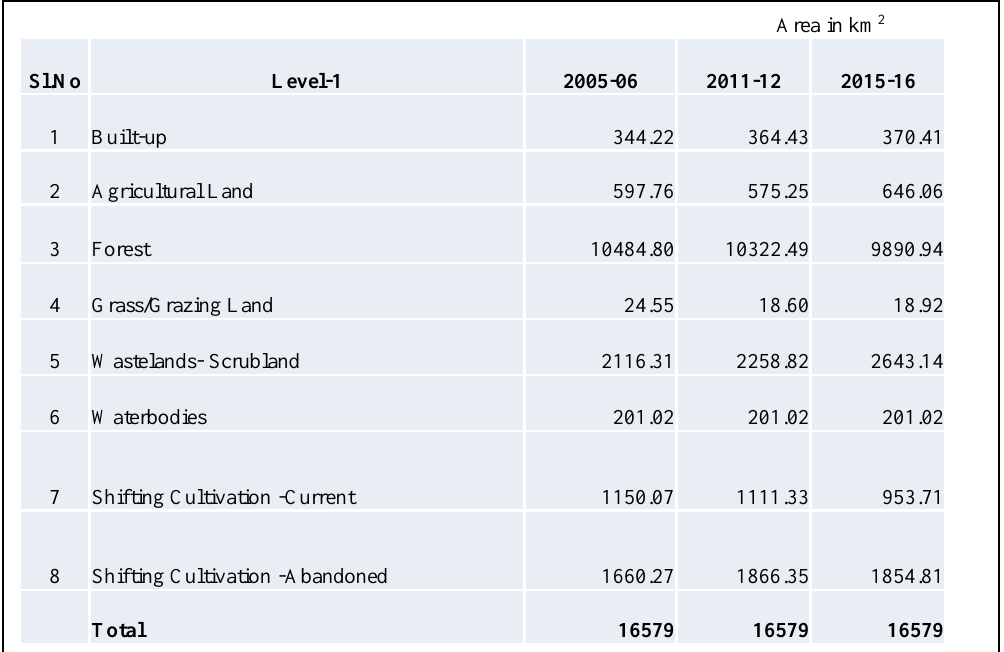
Table 1: Overview of land use pattern for the past 10 Years